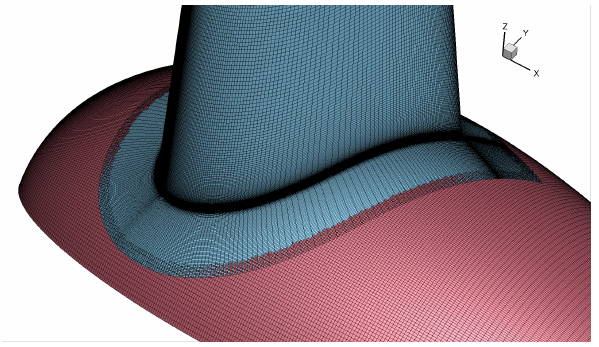
Figure 2. Surface grid of blade and nacelle in the corner region.